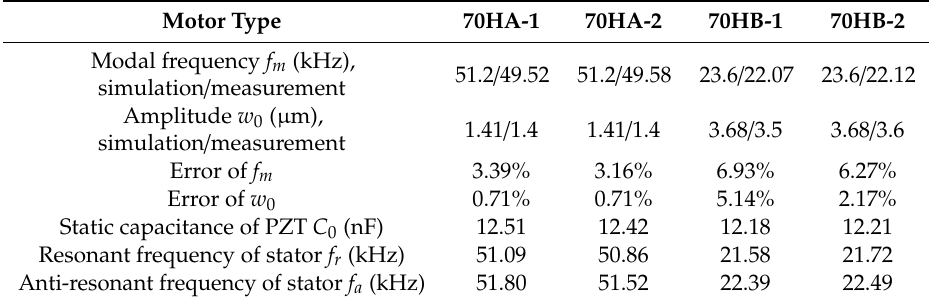
Figure 12. ( a ) PSV-300 scanning Doppler laser vibration measurement system; ( b ) measured mode of 70HA; and ( c ) measured mode of 70HB. Table 3. Vibration characteristics measurement of 70HA and 70HB.